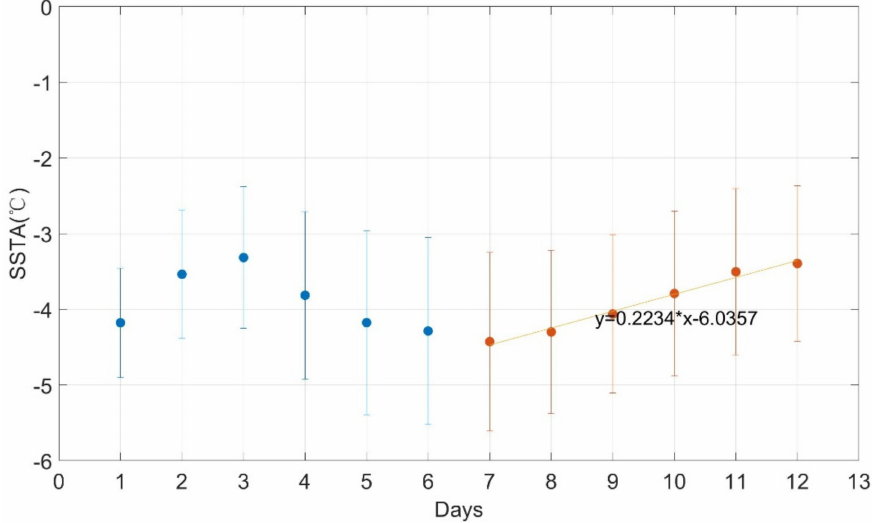
Figure 9. Variation trend of sea surface temperature after typhoon Lingling passes through. First, according to the available typhoon data, no other typhoon appeared in the central part of the South China Sea a week before or after Lingling. Yang et al. studied the surface height data of the South China Sea and found an obvious cold vortex near the typhoon track one week before the formation of Typhoon Lingling. After the typhoon, the scope of the cold vortex expanded and the cooling intensity was greatly strengthened [28].